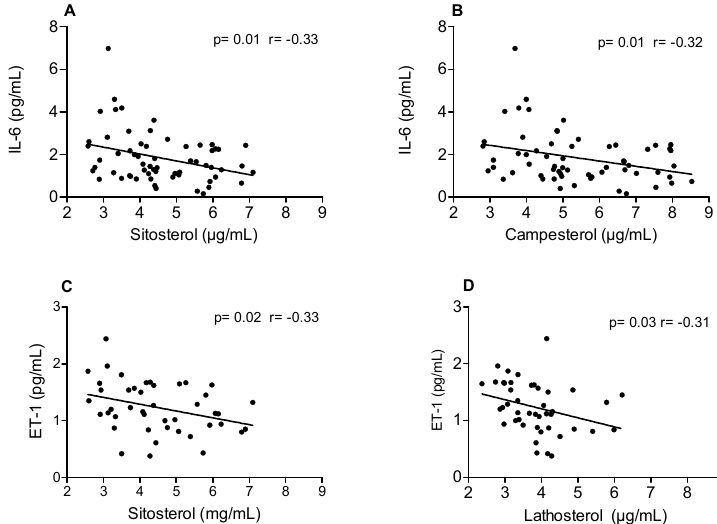
Figure 1. Correlation between markers of cholesterol absorption with interleukin-6 (IL-6) and markers of cholesterol absorption and synthesis with endothelin-1 (ET-1).